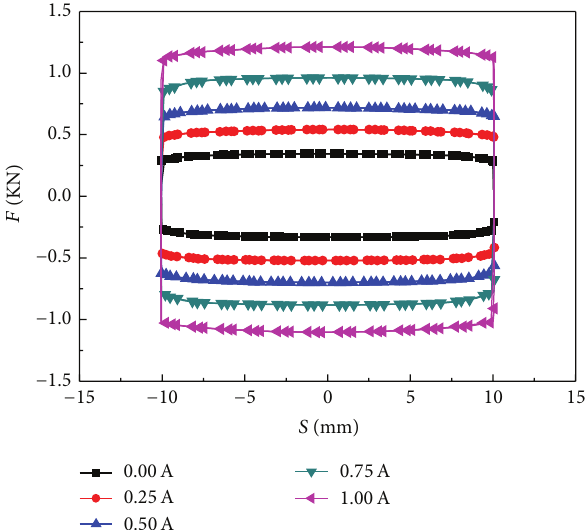
Figure 17: Damping force under different applied